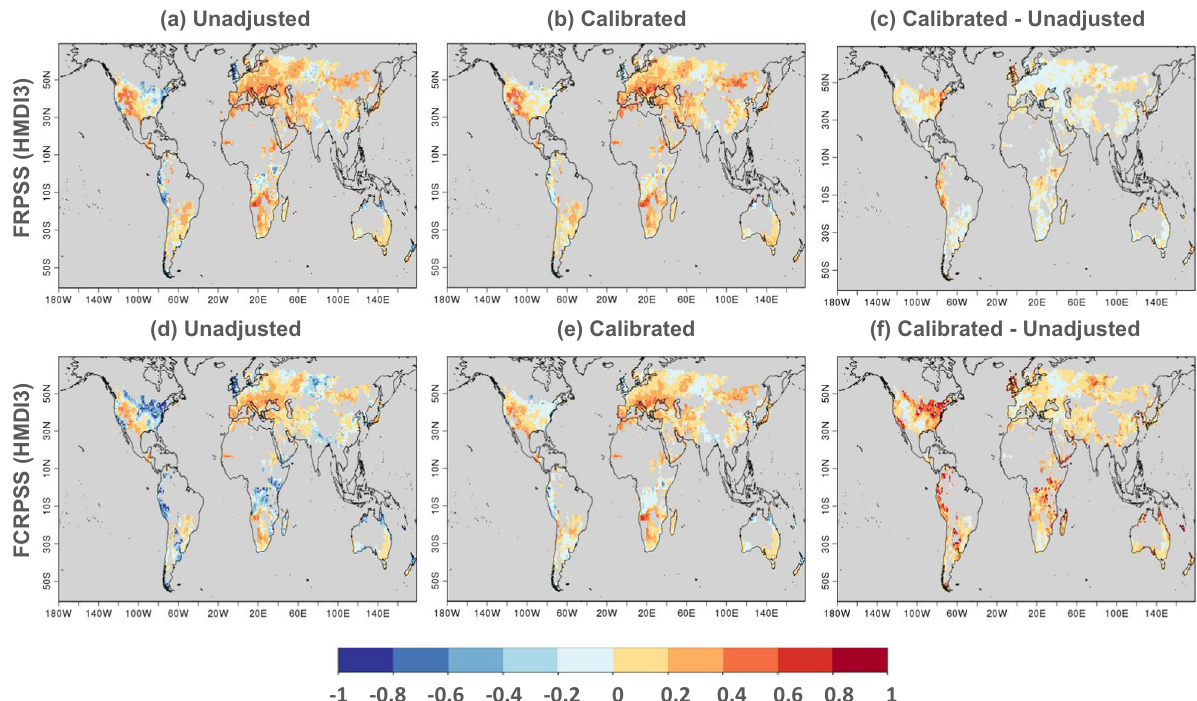
Fig. 3 Predictive skill of the heat stress index. Same as Fig. 1 but for the Heat Magnitude Day index